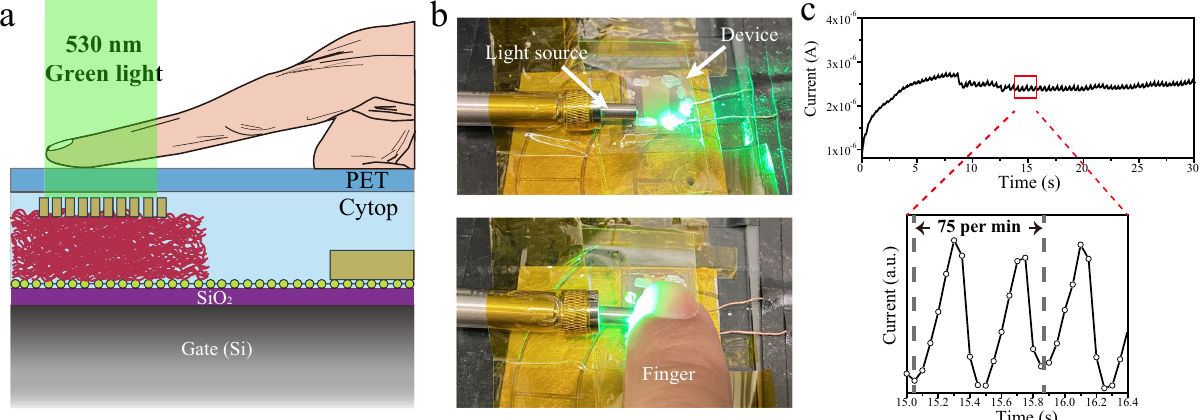
Fig. 4 Supramolecular nanowires system comprising health-monitoring sensors. a Device con fi guration of the transmission-based photoplethysmogram (PPG) sensor. b Photographs of the setup for the real-time heart-rate (HR) measurement based on the PTCDI-C8 nanowires vertical phototransistors. c Long-term measurement of the pulse signal measured from vertical phototransistors at resting